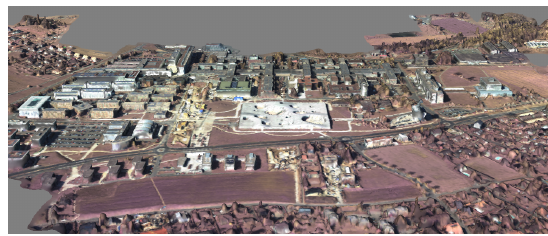
Figure 5. digital elevation model with texture, created using Ag- isoft PhotoScan with our RGB and navigation